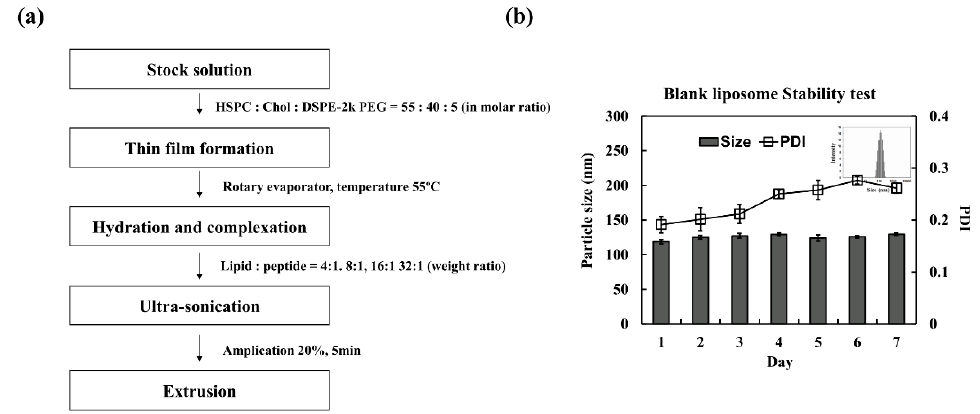
Figure 2. ( a ) Preparation method of liposome and ( b ) stability of the prepared liposome in saline. Table 1. Characterization of peptide complexed